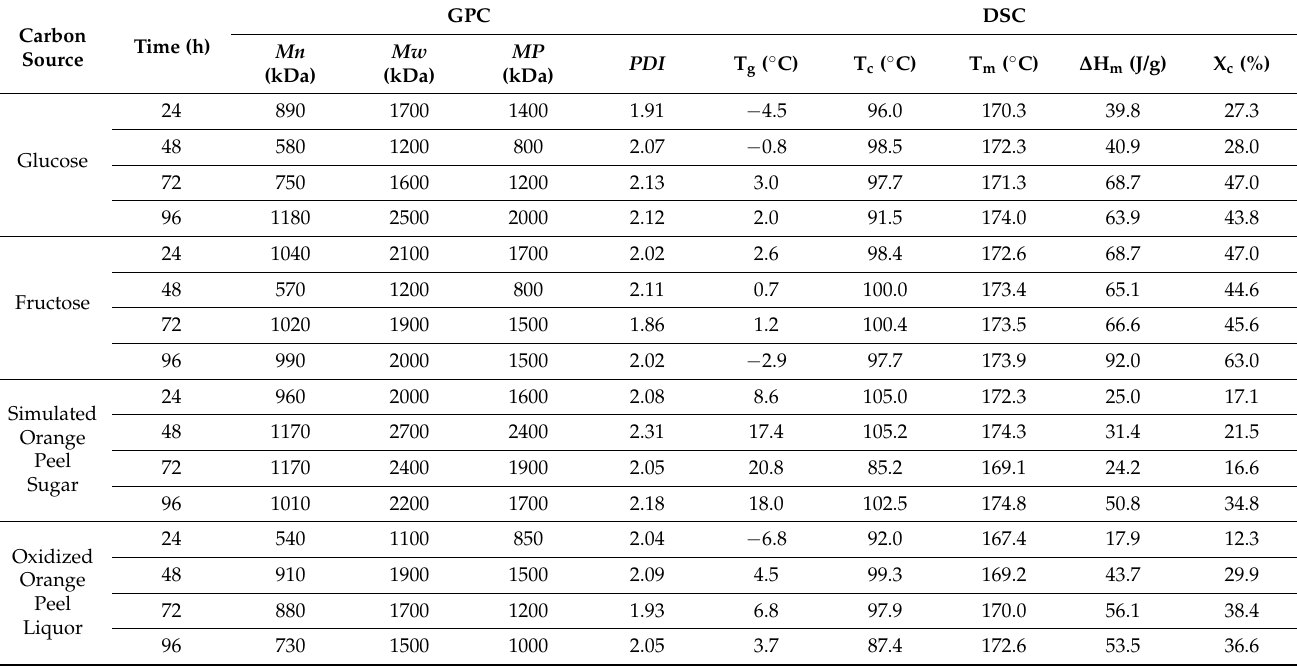
Table 1. Physical properties of the extracted PHB from different carbon sources obtained by GPC and DSC analysis. The degree of crystallinity was calculated by considering melting enthalpy of 100% crystalline PHB of 146 J/g